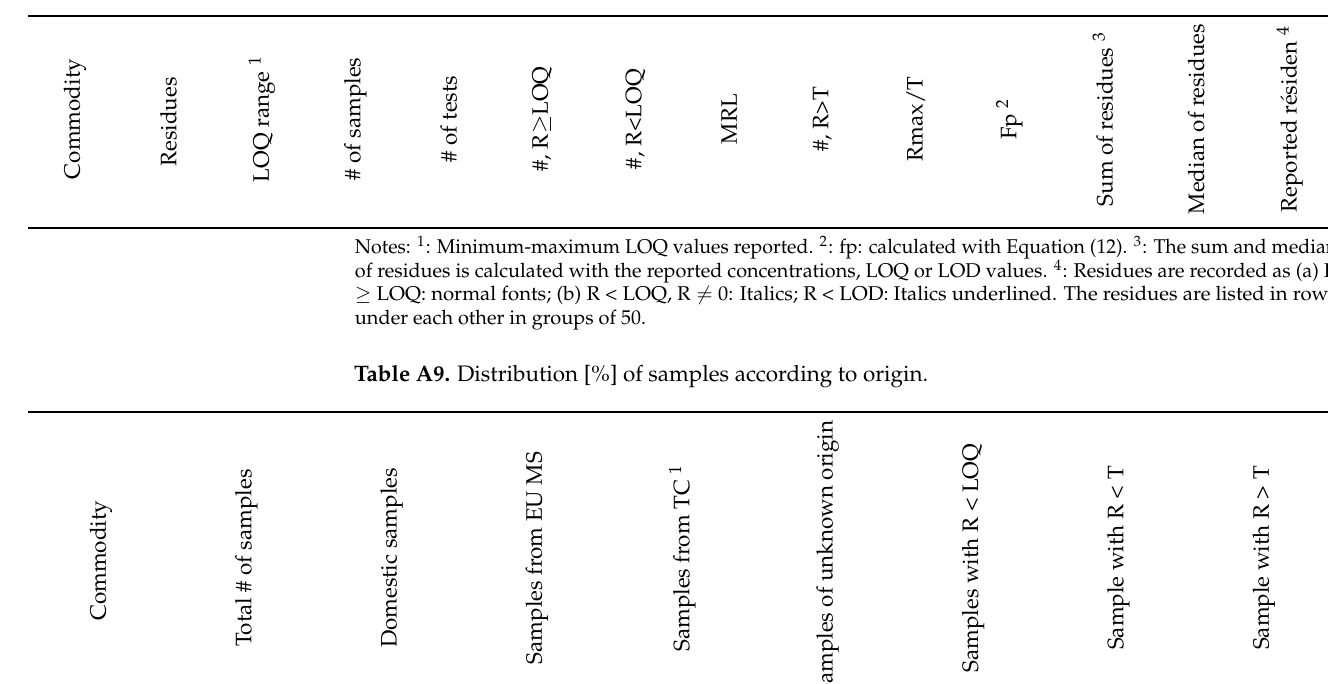
Table A8. Distribution of individual residue values.